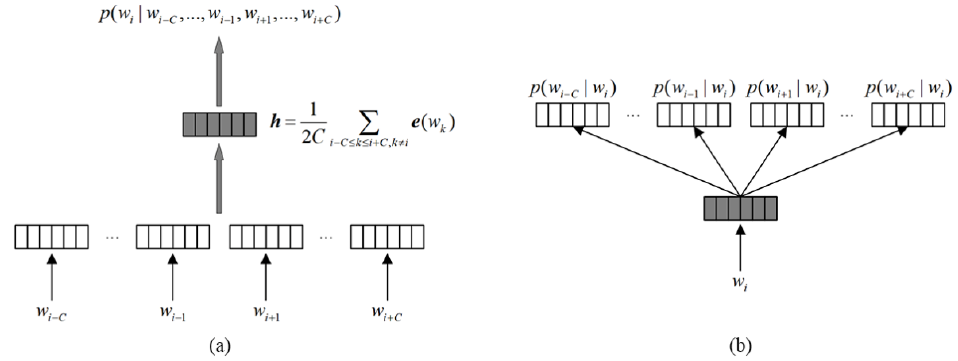
Figure 3. Schematic diagram of CBOW model and skip-gram model. ( a ) CBOW model. ( b ) Skip- gram model.